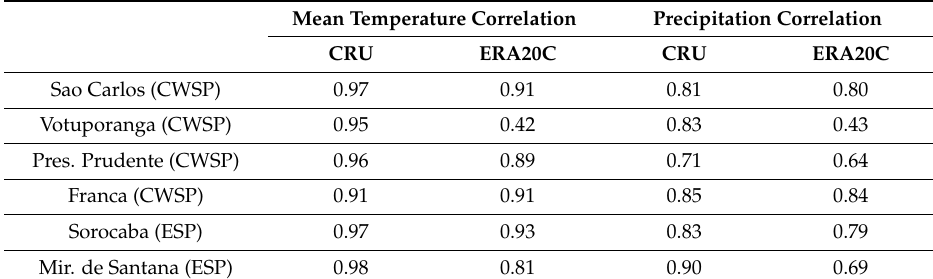
Figure 9. As in Figure 6, but for the CWSP region.